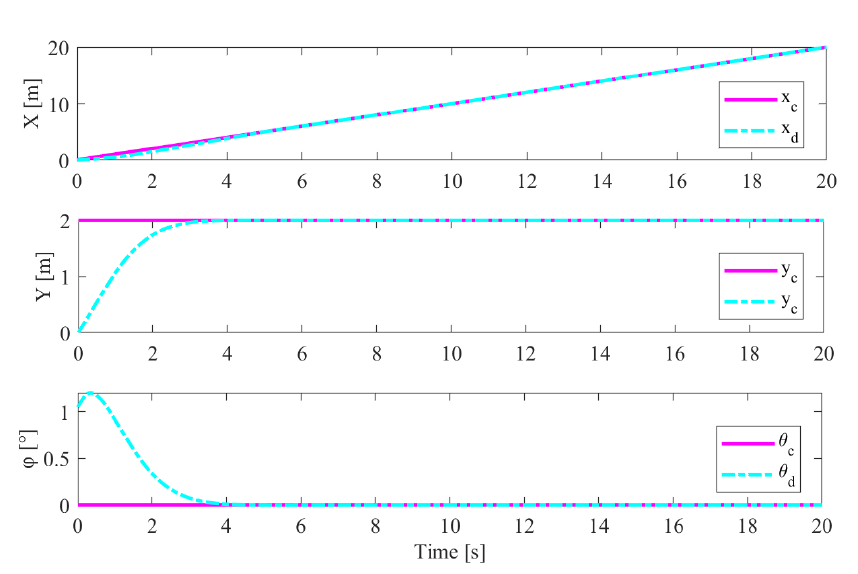
Figure 10. Longitudinal position, lateral position and yaw angle.